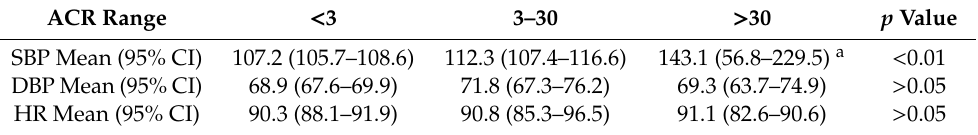
Table 3. E ff ect of haemodynamic parameters on albumin to creatinine ratio